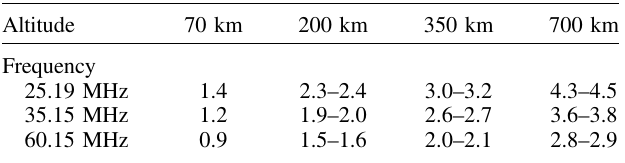
Table 1. The Fresnel length at altitudes of 70 km, 200 km, 350 km, and 700 km for three different frequencies received by LOFAR station CS002. The ranges represent calculation using the source elevation for the start and for the end of the fi rst hour of observation. Values are in